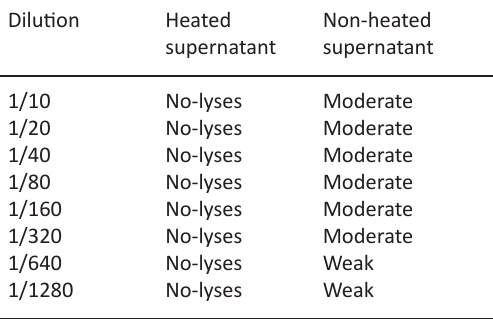
Table 2. Hemaaglutination test for heated and non-heated supernatant of S . dysenteries